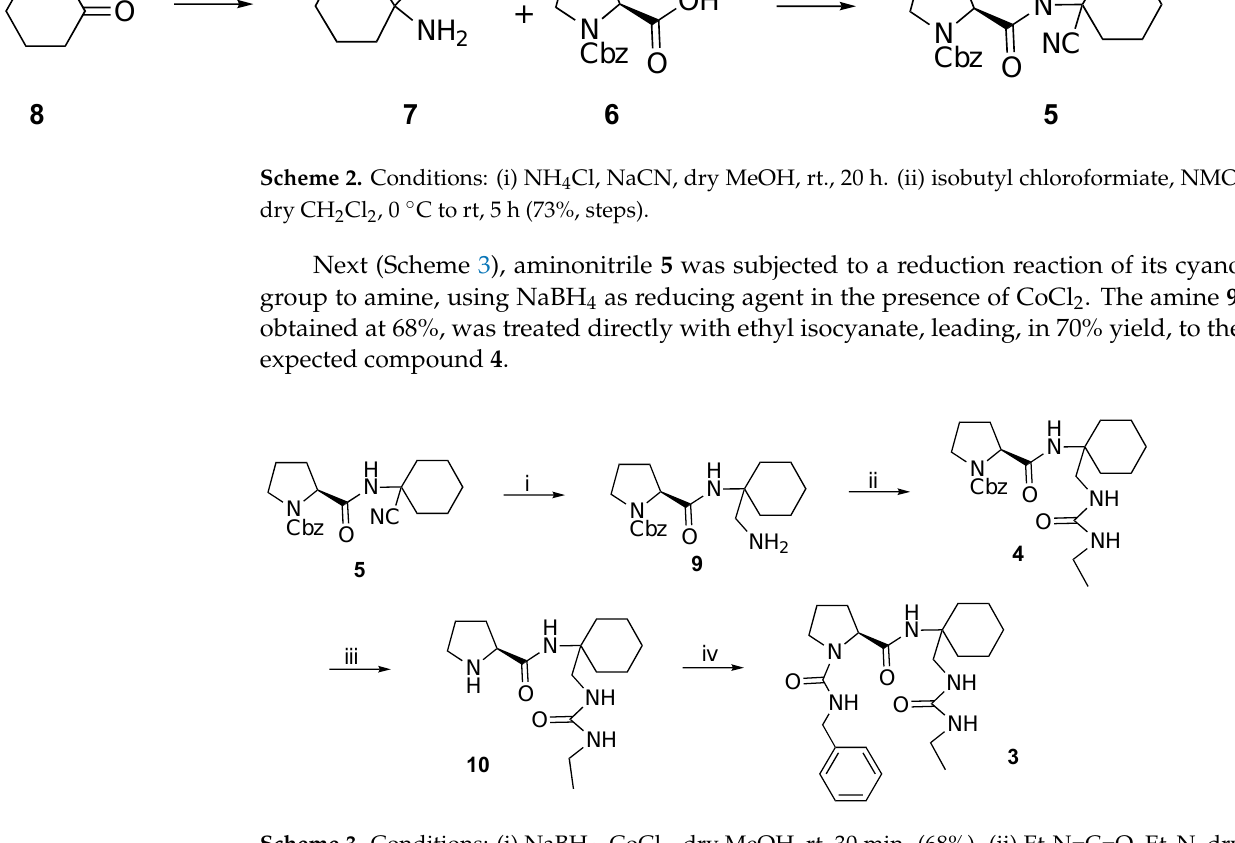
Figure 3. Structure of peptidomimetic 3 , detailing the nomenclature system used for its structural study. (For the units: Urea/Ethyl, Cy, Pro and Bn. For the positions in each unit: Greek alphabet. For NH: H 1 , H 2 , H 3 and H 4 ).